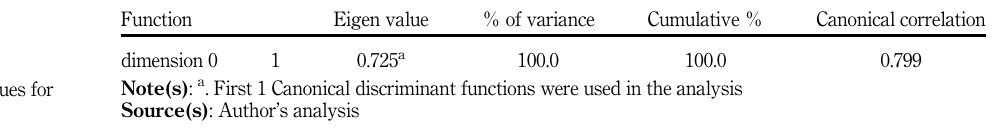
Table 2. Group statistics for websites